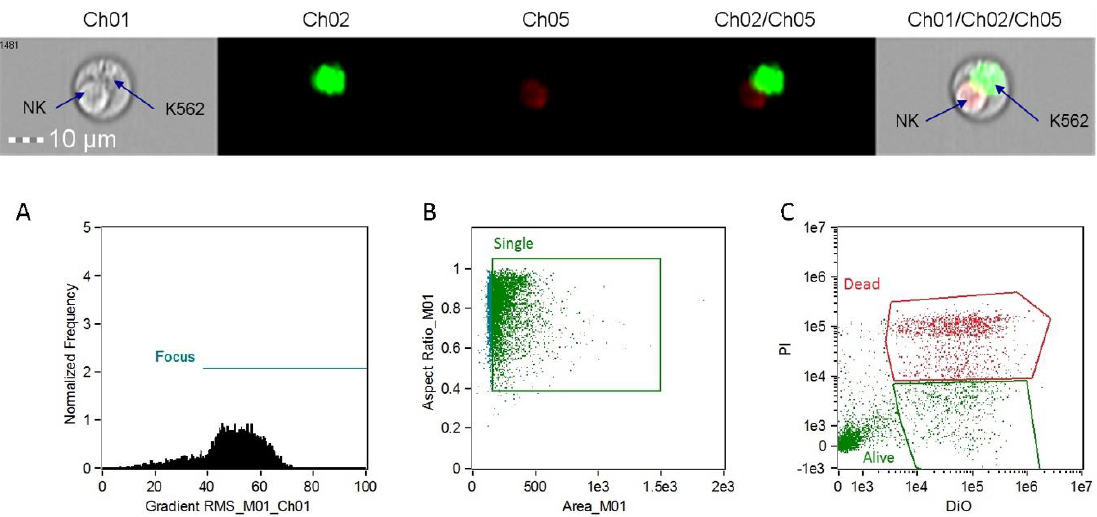
Figure 1. Image data collected from the ImageStream ® X Mark II Imaging Flow Cytometer. In the middle section, target cells (K562) are labeled in green (diotadecyloxacarbocyanine perchlorate, DiO) and dying cells are labeled in red (propidium iodide, PI). The images on the ends represent a doublet event showing an apoptotic natural killer (NK) cell and a live K562 target. ( A ) Focus cell analysis histogram; ( B ) single cell analysis scatterplot; ( C ) target cell staining analysis scatterplot.